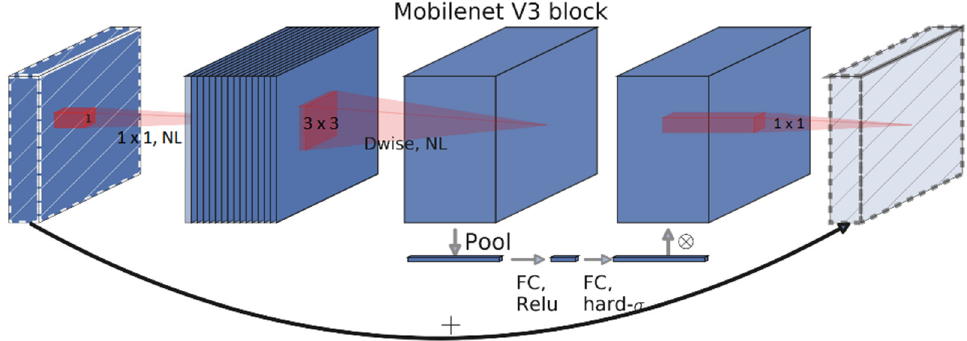
Figure 5. Building blocks of MobileNet V3 architecture.